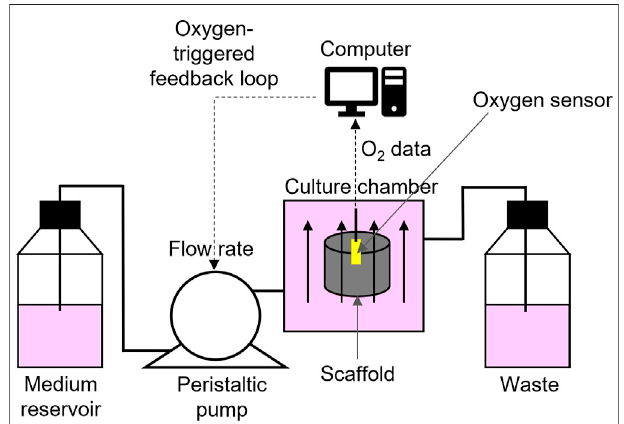
FIGURE 3 | Schematic view of the oxygen-triggered feedback mechanism: acomputer controlled peristaltic pumpdrivesfreshmedium from the reservoir through the perfusion bioreactor into the waste reservoir. The oxygen sensor (yellow) constantly senses the oxygen concentration in the centre of the scaffold and sends data to the computer, which controls the pump